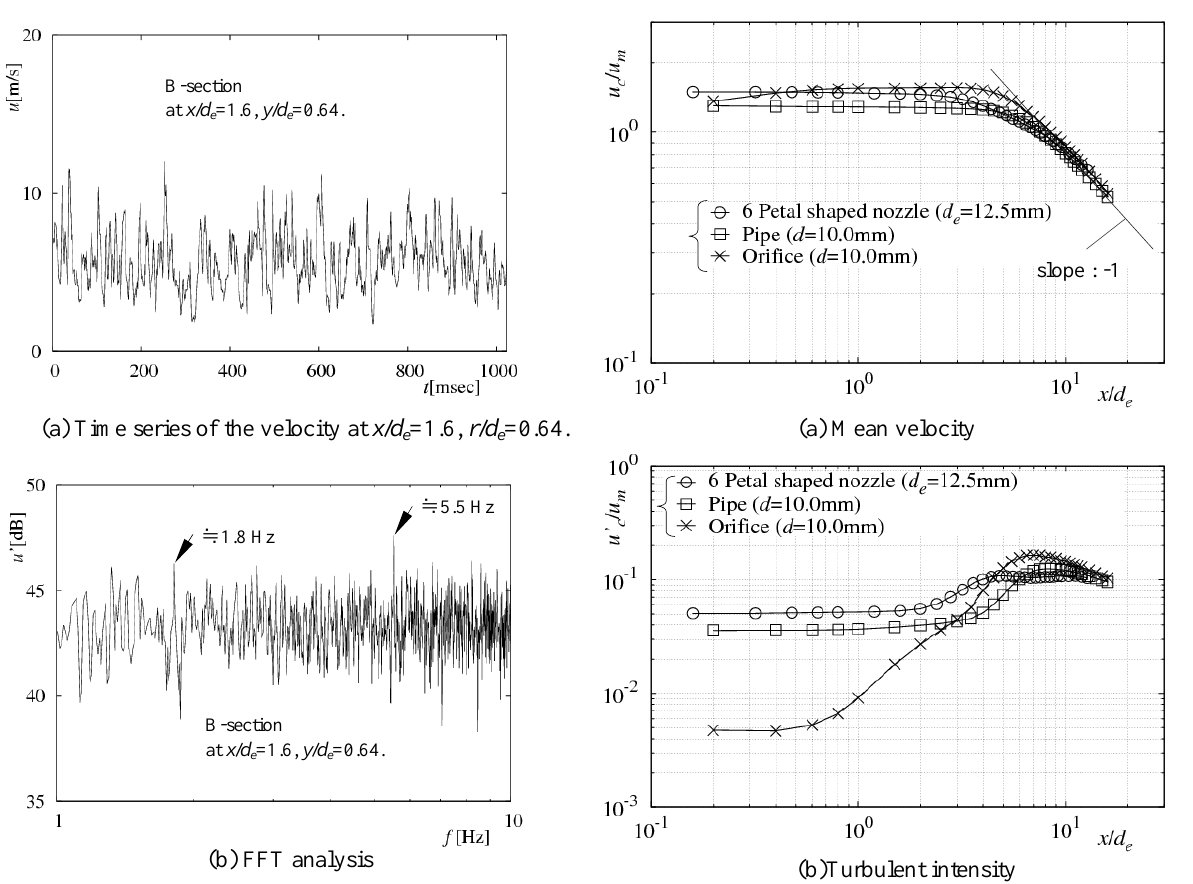
Fig.8 Fluctuation of jet, velocity